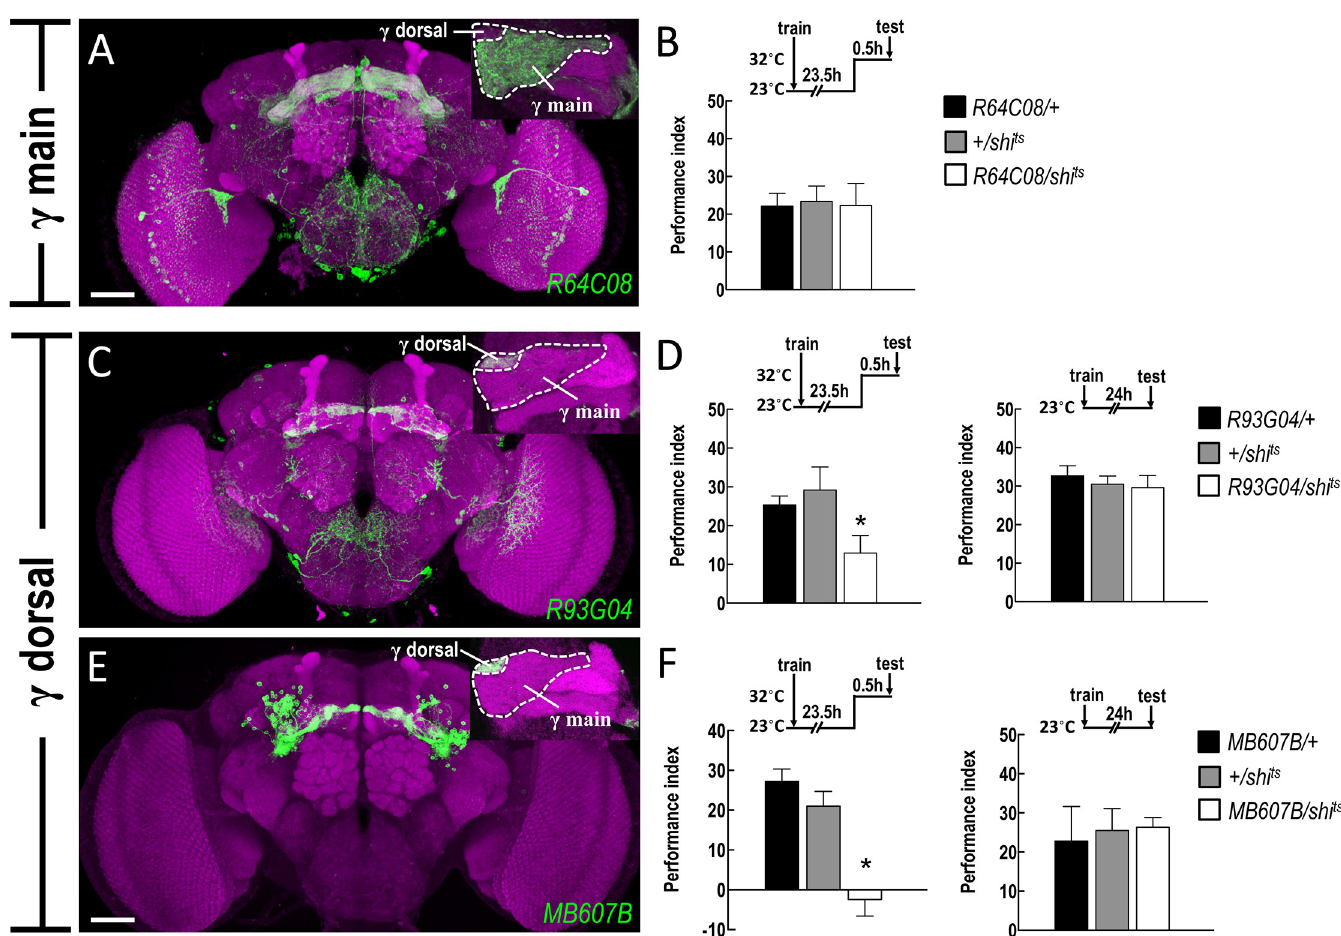
Fig 4. wLTM retrieval requires neurotransmission from γ dorsal neurons. (A) The expression pattern of R64C08-GAL4 and the high-magnification signal from the frontal confocal cross section of the MB horizontal lobe (top right inset). The brain neuropils were immunostained with anti-DLG antibody (magenta). Scale bar represents 50 μ m. (B) Blocking neurotransmission from γ main neurons ( R64C08-GAL4 ) using shi ts during retrieval did not affect wLTM. The 24-hour water-reward memory was normal in R64C08-GAL4 > UAS-shi ts flies as compared to their internal control groups in 32˚C. Each value represents mean ± SEM (N = 10). p > 0.05; one-way ANOVA. (C) The expression pattern of R93G04-GAL4 and the high-magnification signal from the frontal confocal cross section of the MB horizontal lobe (top right inset). (D) Blocking neurotransmission from γ dorsal neurons ( R93G04-GAL4 ) using shi ts during retrieval disrupted wLTM (left panel). Each value represents mean ± SEM (N = 12). � , p < 0.05; one-way ANOVA followed by Tukey’s test. The 24-hour water-reward memory was normal in R93G04-GAL4 > UAS-shi ts flies as compared to their internal control groups in 23˚C (right panel). Each value represents mean ± SEM (N = 6). p > 0.05; one-way ANOVA. (E) The expression pattern of MB607B-GAL4 and the high-magnification signal from the frontal confocal cross section of the MB horizontal lobe (top right inset). The brain neuropils were immunostained with anti-DLG antibody (magenta). Scale bar represents 50 μ m. (F) Blocking neurotransmission from γ dorsal neurons ( MB607B-GAL4 ) using shi ts during retrieval disrupted wLTM (left panel). Each value represents mean ± SEM (N = 8~9). � , p < 0.05; one-way ANOVA followed by Tukey’s test. The 24-hour water- reward memory was normal in MB607B-GAL4 > UAS-shi ts flies as compared to their internal control groups in 23˚C (right panel). Each value represents mean ± SEM (N = 6). p > 0.05; one-way